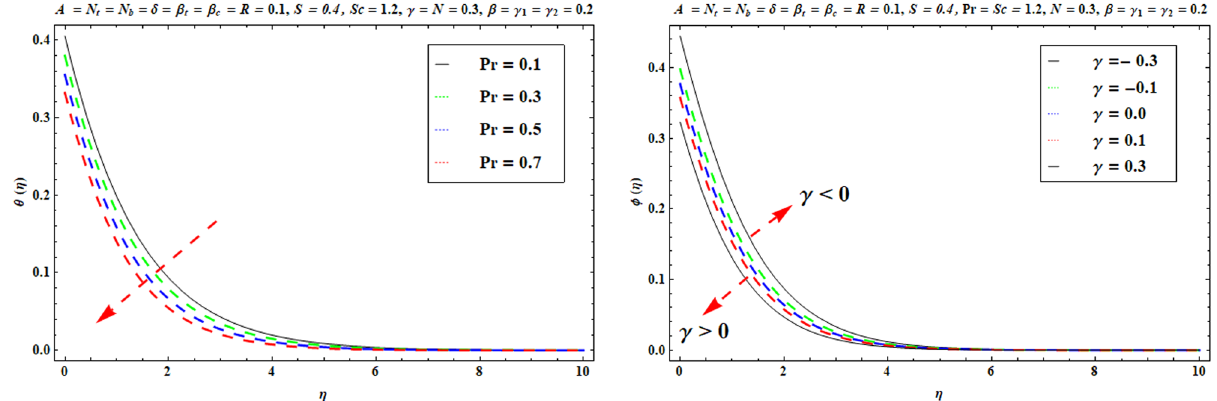
Figure 16: ϕ η ( ) versus γ .